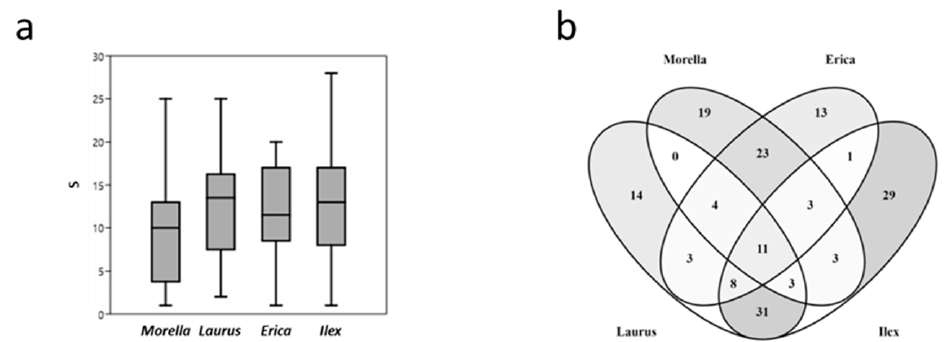
Figure 3. Boxplot of richness (S) by phorophyte ( a ) and Venn diagram of unique and shared lichen taxa of four phorophytes ( Erica canariensis , Ilex canariensis , Laurus novocanariensis, and Morella faya ) in all studied islands ( b ).